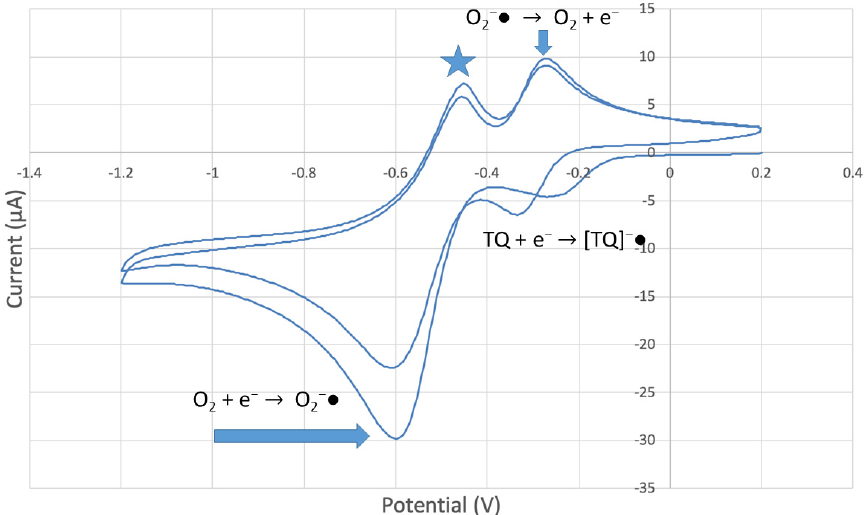
Figure 10. CV of TQ 0.00074 M solution (1280 µ L aliquot) saturated with the O 2 /N 2 mixture. The star and arrows are described in the text.